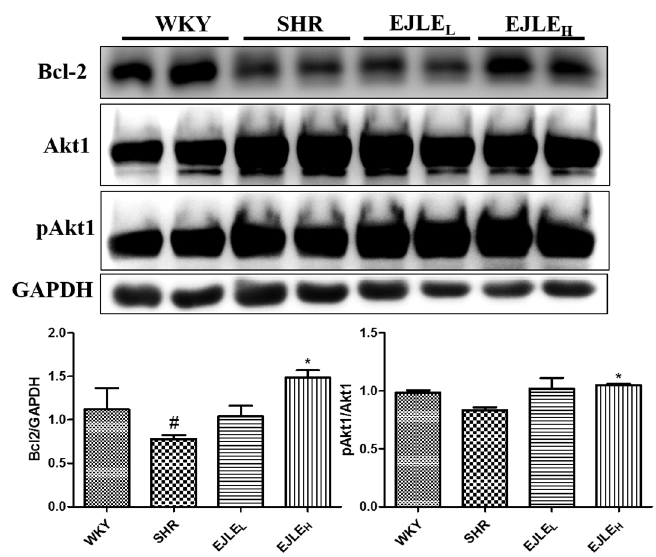
Figure 4. Effect of EJLE on the survival markers in the heart tissue sections of SHR animals. Representative Western blot depicting the changes in the levels of Bcl-2, Akt1, and pAkt1 proteins involved in the survival pathways in normotensive rats (WKY), spontaneously hypertensive rats (SHRs) and SHRs supplemented with low dose (EJLE L ) and high dose (EJLE H ). Results were analyzed by one-way ANOVA using Tukey test with GraphPad Prism software (Version 5.0). # ( p < 0.05) indicate significant differences when compared to normotensive WKY group (SHR vs. WKY); whereas * ( p < 0.05) indicate significant differences when compared to SHR group.